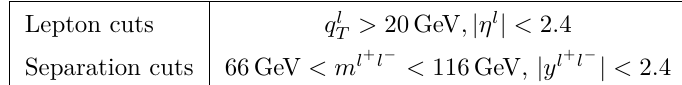
Table 1. Fiducial cuts for Z → l + l − at